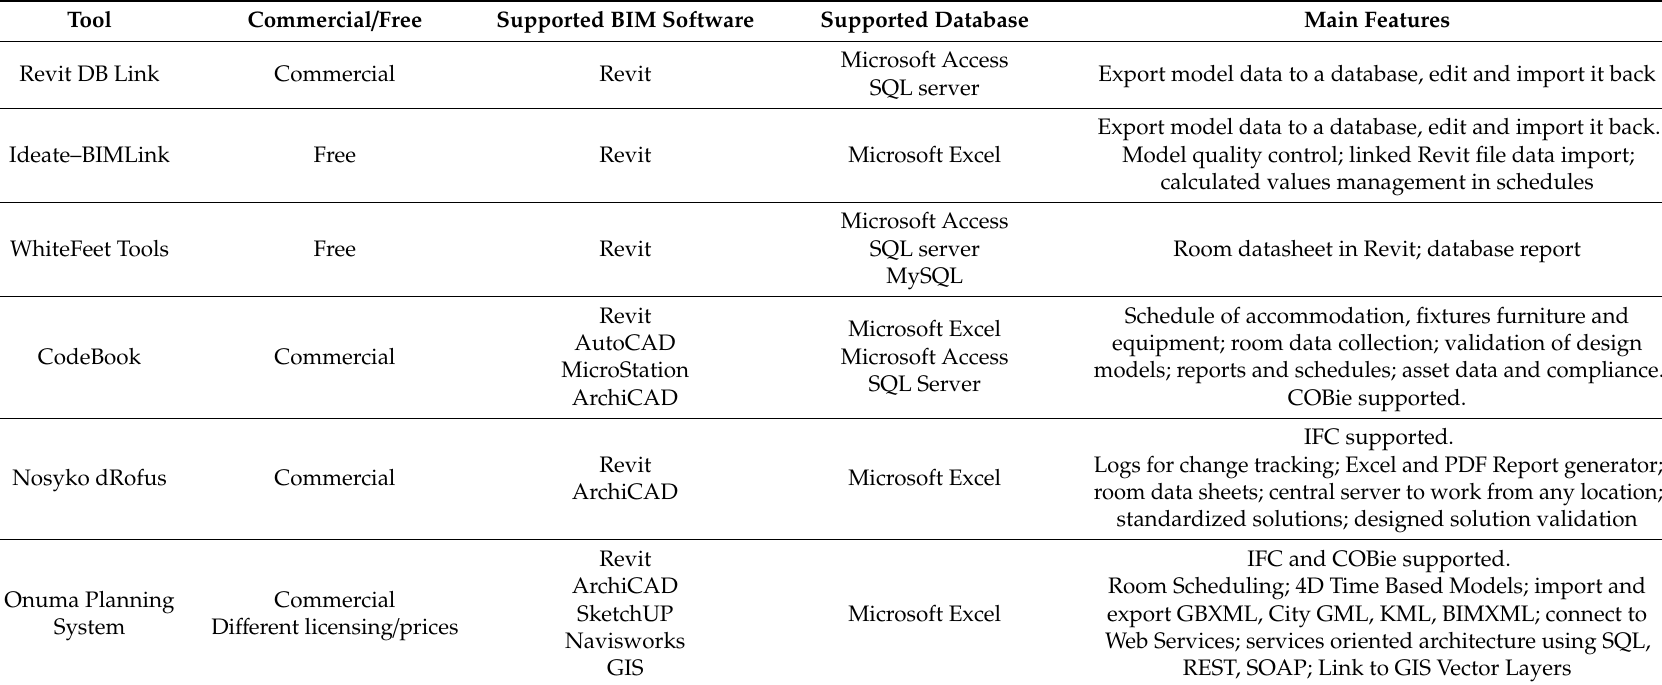
Table 1. Main features of the mentioned tools for data management in Building Information